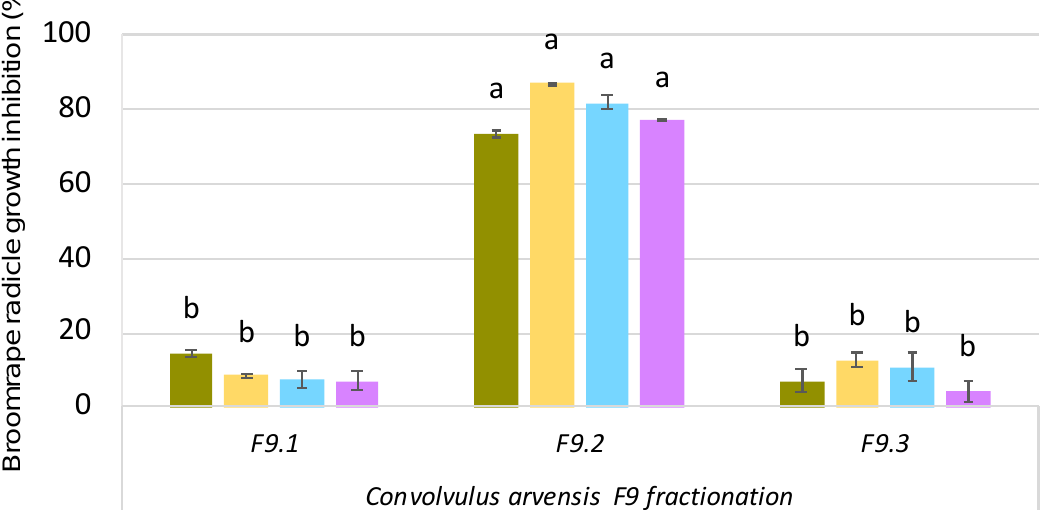
P. ramosa Figure 2. Cont